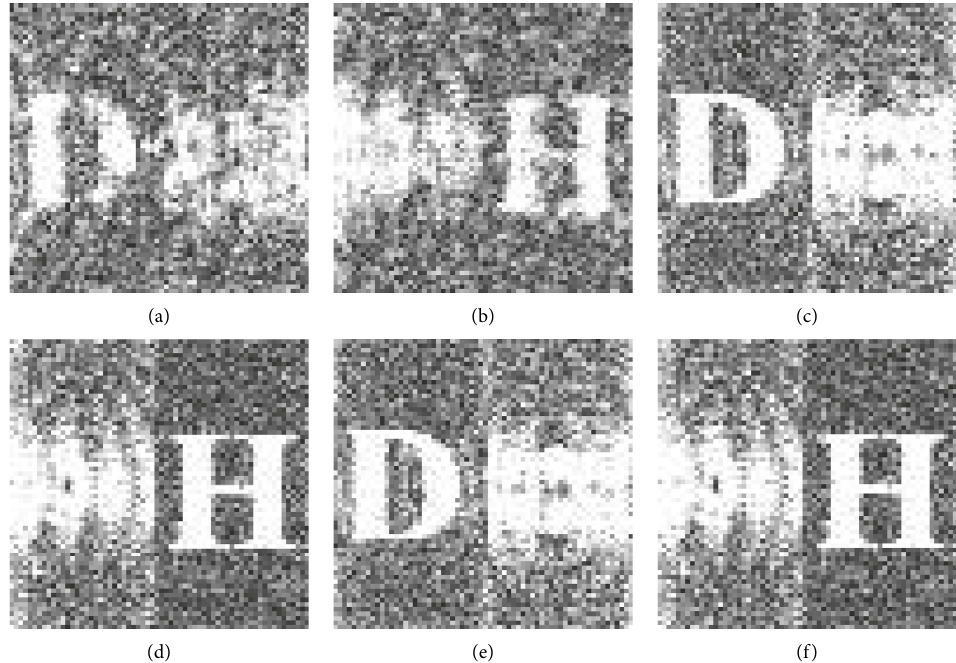
Figure 9: Intensity of the decrypted 3D object scene using correct keys: (a) reconstructed at first plane with 64 × 64 × 8% measurements; (b) reconstructed at second plane with 64 × 64 × 8% measurements; (c) reconstructed at first plane with 64 × 64 × 25% measurements; (d) reconstructed at second plane with 64 × 64 × 25% measurements; (e) reconstructed at first plane with 64 × 64 × 65% measurements; (f) reconstructed at second plane with 64 × 64 × 65%